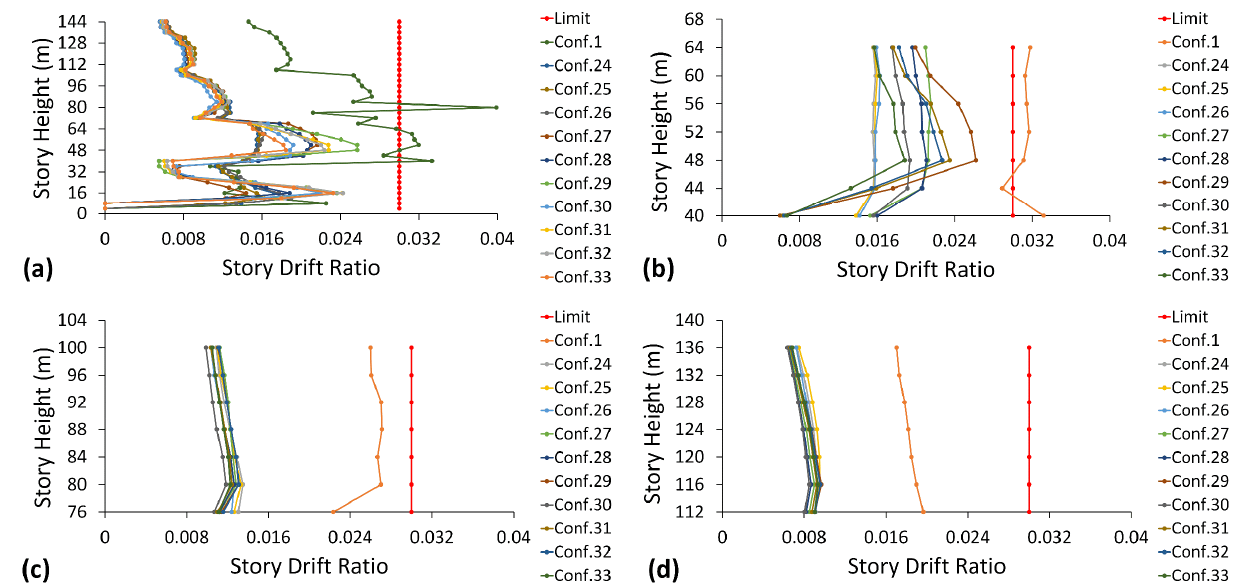
Figure 11. Peak transient story drift of different configurations under the Nahanni earthquake: ( a ) mega ‐ frame, ( b ) first substructure, ( c ) second substructure, and ( d ) third substructure.